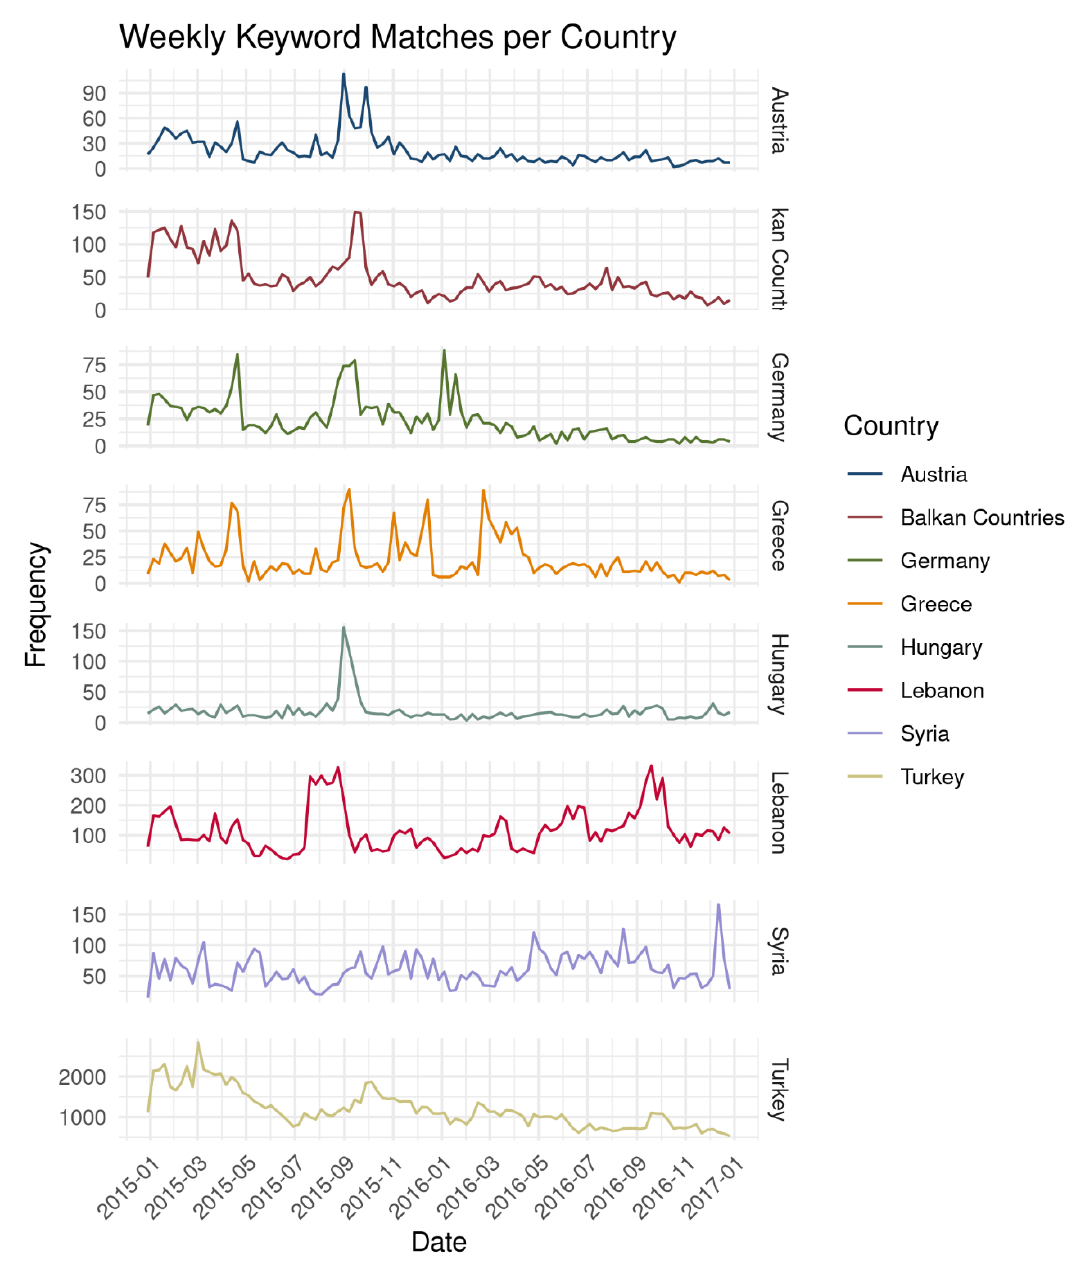
Figure 7. Development of keyword matches for the different languages over time.